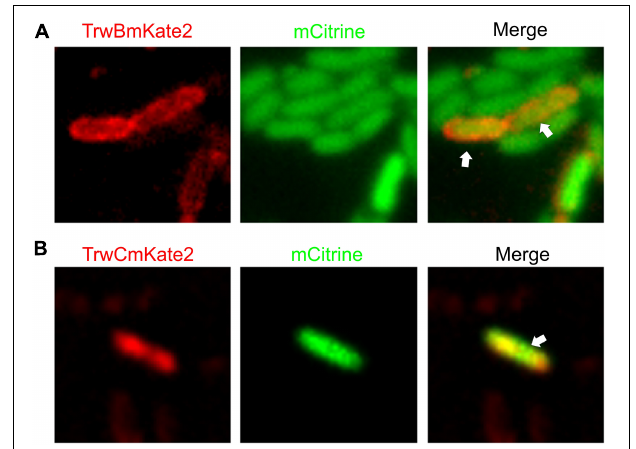
FIGURE 4 | Visualization of transconjugant cells. MG1655 donor cells hosting R388: trwBmKate2 (A) or R388: trwCmKate2 (B) were mixed with UB1637 recipient cells expressing mCitrine. Conjugation was performed in enriched M9 minimal media plates and then, cells were transferred to the microscope for image-recording. Images were recorded at different emission wavelengths (540 and 630 nm, for mCitrine and mKate2, respectively) at the same location, in order to discriminate donor, recipient and transconjugant cells. Merged images show the transconjugant cells in orange ( right panel ). These transconjugants are UB1637 cells expressing mCitrine that, after receiving the R388 plasmid, have started to express TrwBmKate2 (A) or TrwCmKate2 (B) , encoded by the